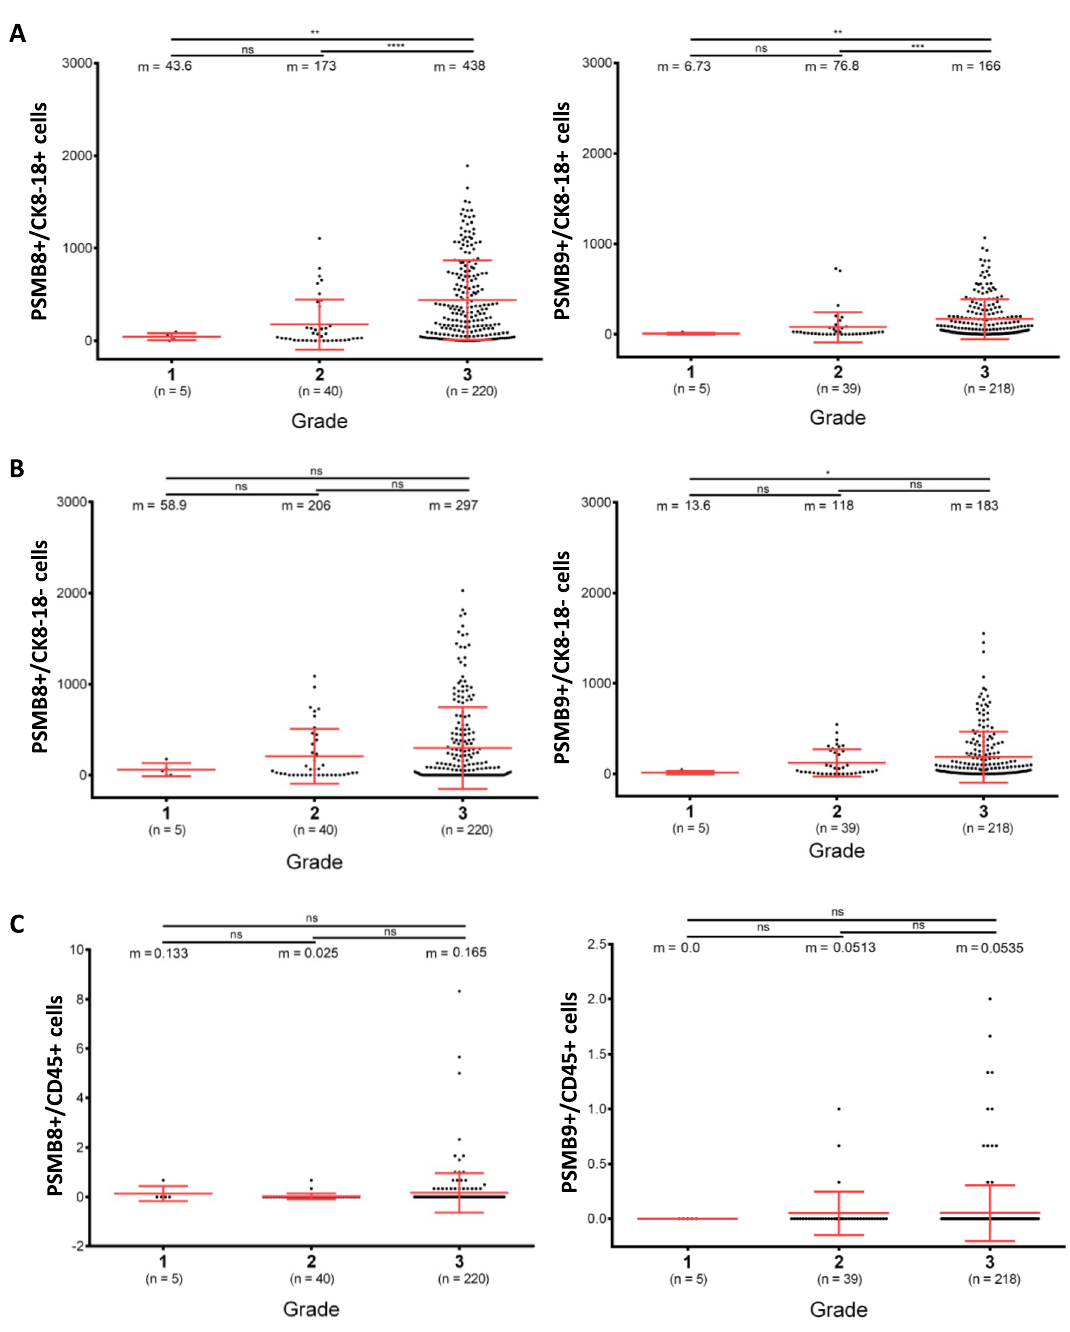
Figure 6. Protein expression of PSMB8 and PSMB9 by tumor cells correlate with breast cancer grades. Quantification of the number of ( A ) tumor cells (CK8-18+), ( B ) stromal cells (CK8-18−) or ( C ) immune cells (CD45+) positive for PSMB8 (left panel) or PSMB9 (right panel) and segregated according to the grade of TNBC cancers. The number of samples from each grade included in the analysis is indicated in brackets below the corresponding group. Mann-Whitney test, ns: p > 0.05, * p ≤ 0.05, ** p ≤ 0.01, *** p ≤ 0.001, **** p ≤